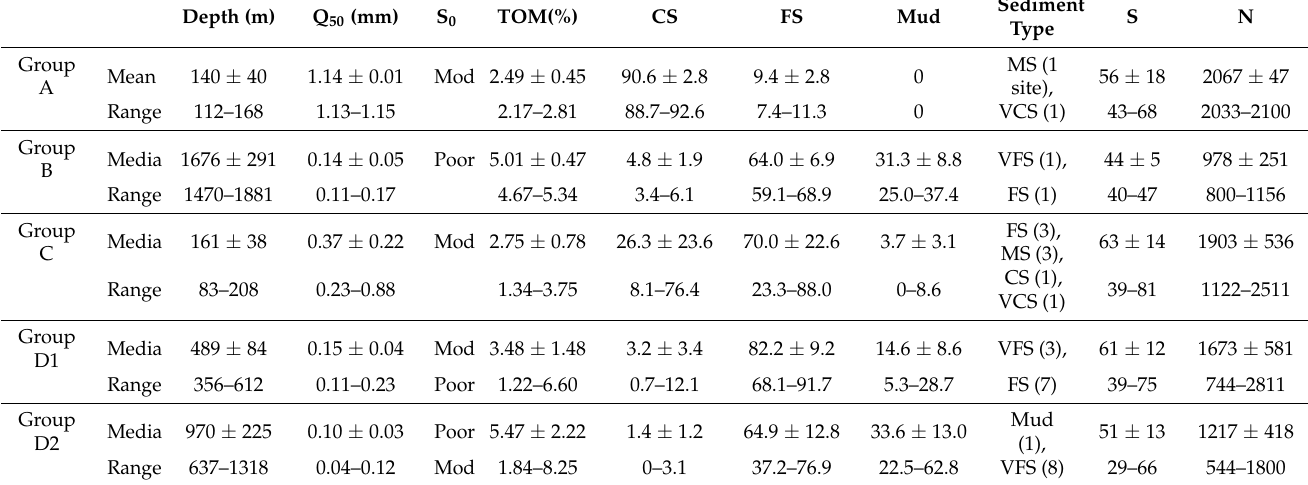
Figure 5. Non-metric multidimensional scaling (nMDS) ordination of sampling sites showing groups determined by cluster analysis, and ordination of sites with values of some environmental variables superimposed (depth; fine sand; mud). Table 2. Abiotic and biotic characteristics of the main infaunal macrobenthic assemblages dis- criminated by the multivariate analysis of abundance data.